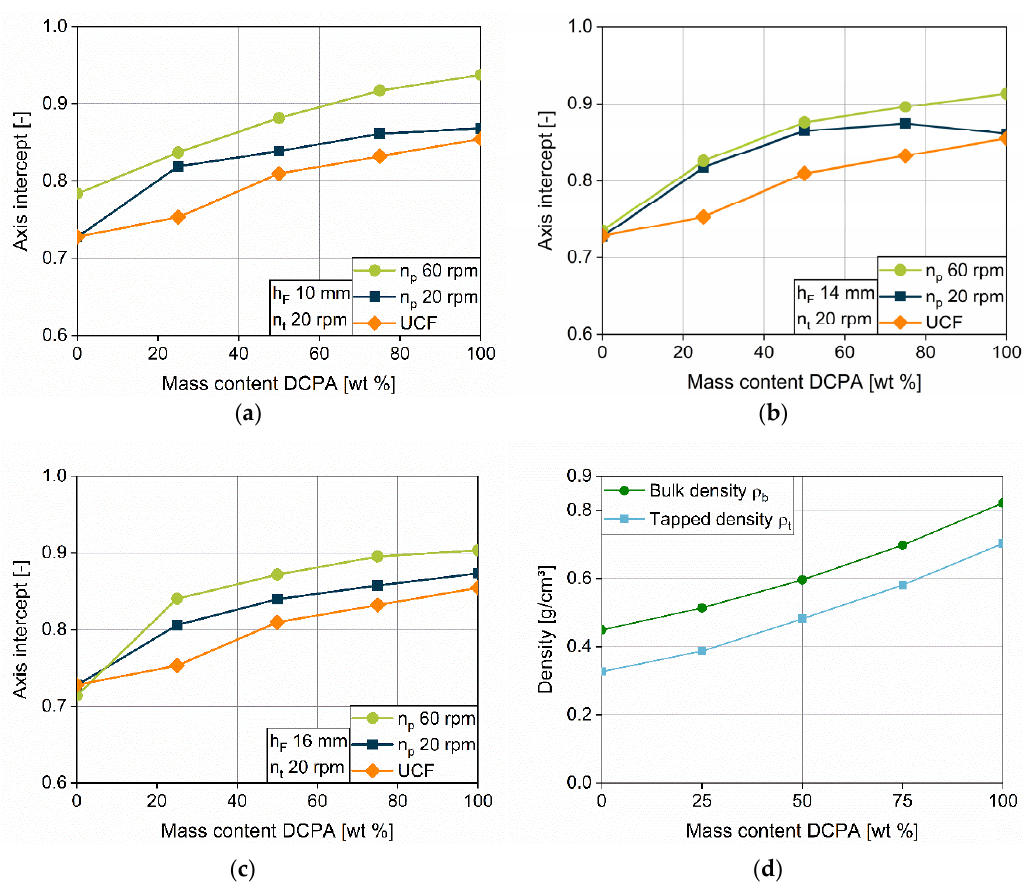
Figure 15. Axis intercept of the linear fits of the overfill ratio in dependence on the mass content of DCPA at a turret speed of 20 rpm at fill depths of 10 ( a ), 14 ( b ) and 16 mm ( c ); Bulk and tapped density of the five formulations used ( d ).